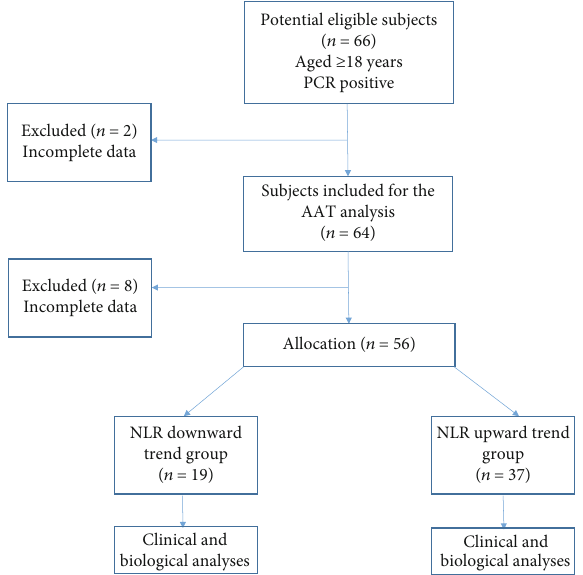
Figure 1: Flow chart of case enrolment in this retrospective observational cohort study between July 2020 and